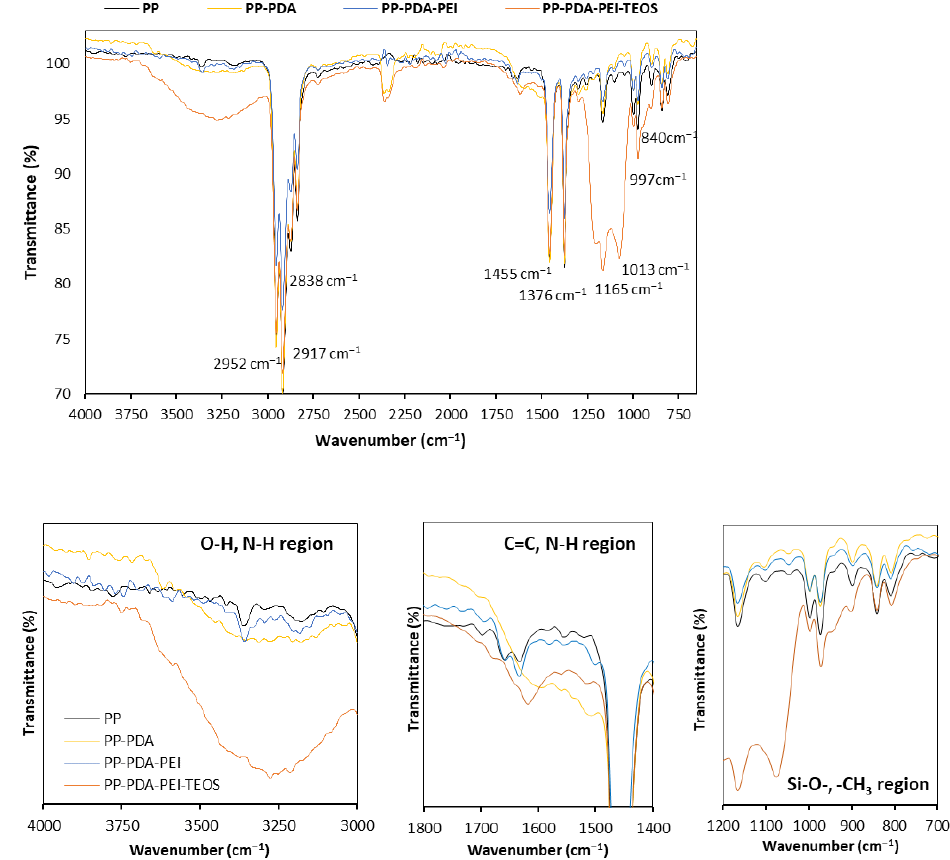
Figure 3. FTIR spectra of the PDA/PEI-supported TEOS deposition on the PP film ( above ) with magnification of specific regions ( below ).